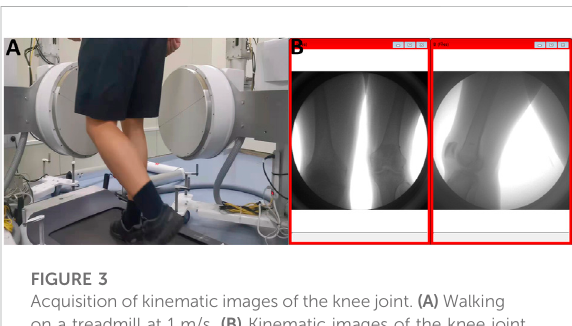
FIGURE 3 Acquisition of kinematic images of the knee joint. (A) Walking on a treadmill at 1 m/s. (B) Kinematic images of the knee joint acquired simultaneously in both directions. FIGURE 4